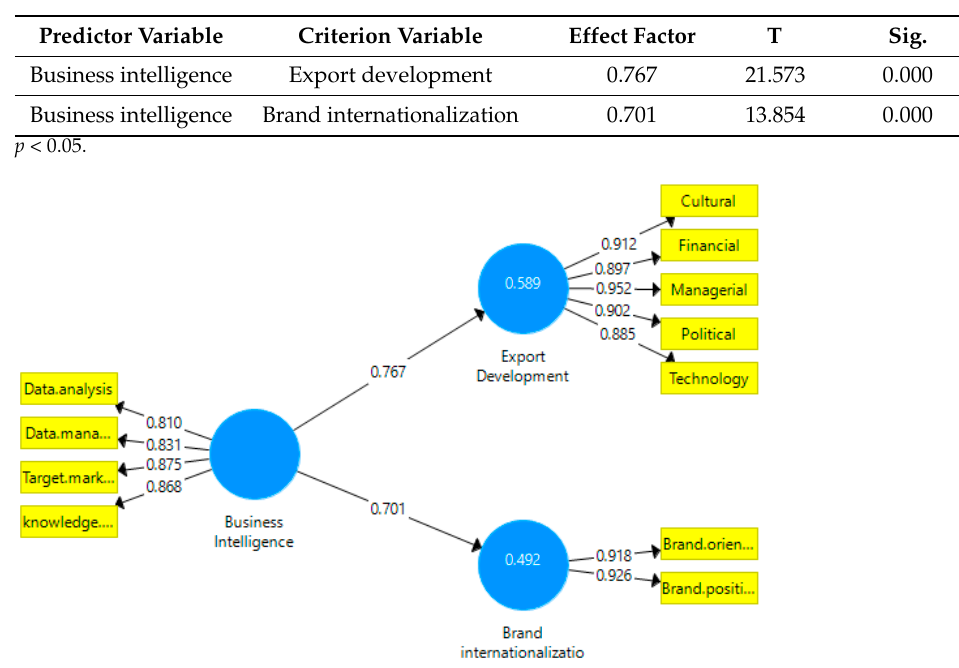
Table 3. Effect factor of applying business intelligence on export development and brand internation- alization in large industrial firms.